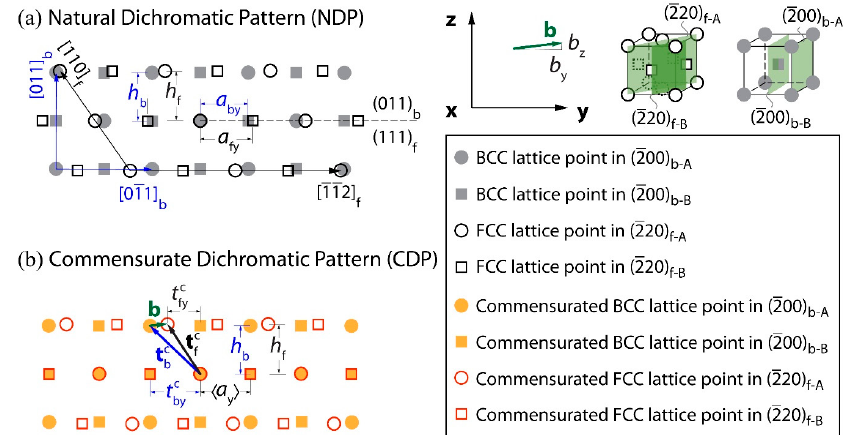
Figure 1. Identification of the variables of topological model at ideal N-W OR. ( a ) Natural dichromatic pattern; ( b ) Commensurate dichromatic pattern. Subscript ‘A’ and ‘B’ refers to the projection of alternating layers of ( − 2 0 0) b and ( − 2 2 0) f , both of which have an ABAB type stacking sequence. Axis x parallels [ − 1 1 0] f // [ − 1 0 0] b ; axis y parallels [ − 1 − 1 2] f // [0 − 1 1] b ; and axis z parallels [1 1 1] f // [0 1 1] b . Table 1. The numerical solutions of orientation relationship (OR) and interface orientation (IO) determined by the topological model. ε ° ) ϕ ( ° ) θ ° ) θ ° ) yy b y (nm) b z (nm) <h > (nm) θ ( f ( b ( − 0.0928